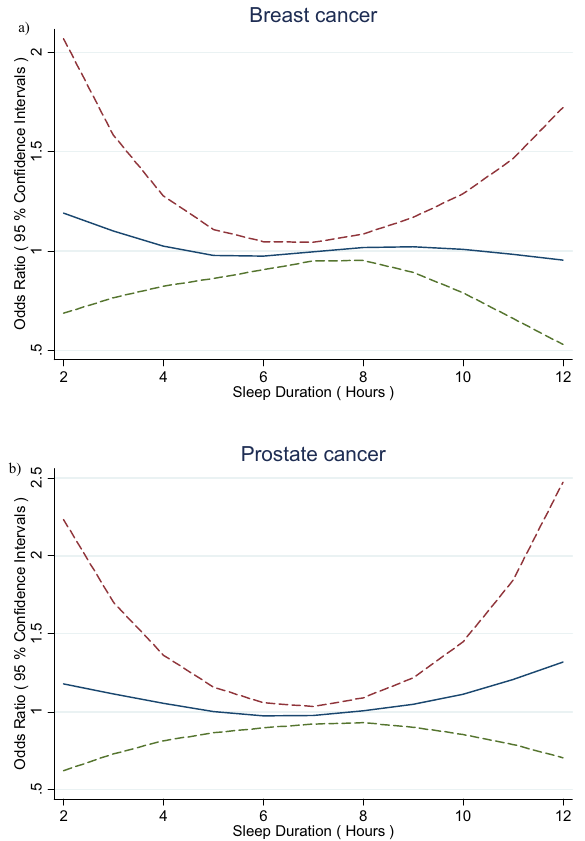
Figure 1. General additive models of associations of habitual sleep duration (h) and ( a ) breast and ( b ) prostate cancer risk, MCC-Spain,